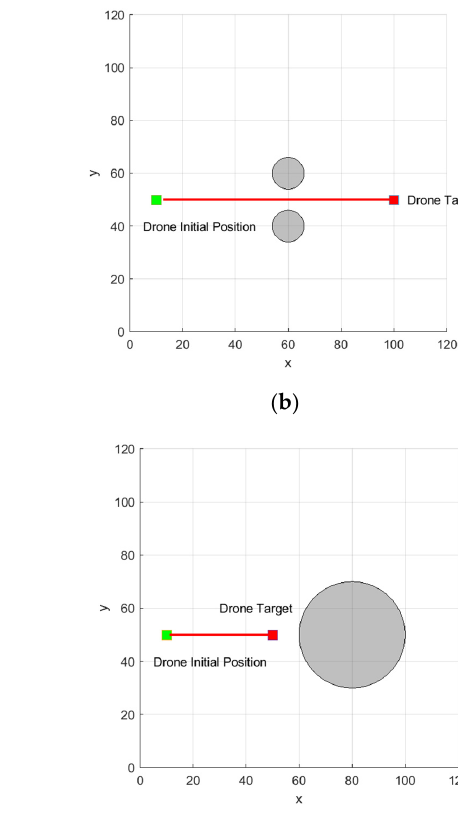
Figure 13. Escape local optimal solution using virtual-target gravitational field. ( a ) Traditional artificial-potential-field method. ( b ) Improved artificial-potential-field method.